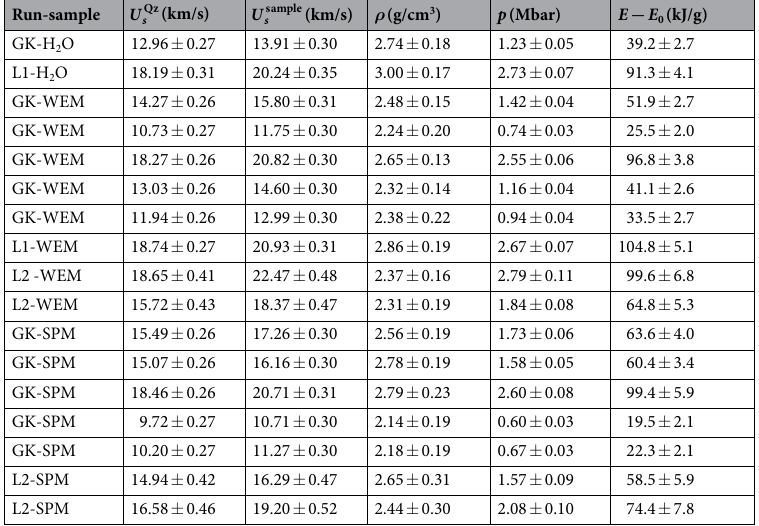
Table 1. Experimental data on pure water, WEM and the SPM. The run prefixes GK, L1, and L2 identify the campaign at GEKKO XII and the first and second campaign at LULI2000, respectively. The ρ - p -( E − E 0 ) data are relative to the sample under